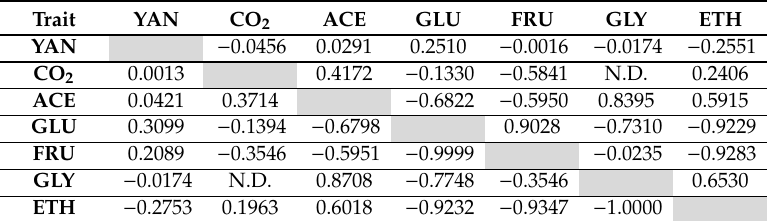
Table 2. Phenotypic (above diagonal) and genetic (below diagonal) correlations for the seven oenological traits